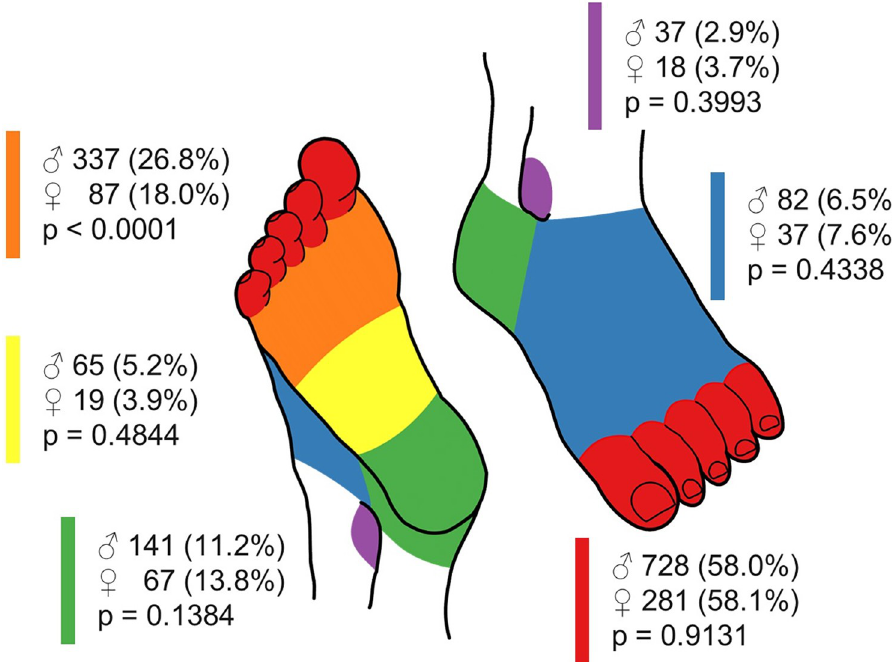
Fig 1. Location of the index DFU. A color-coded diagram was used by the DFC to indicate the location of the index DFU: Plantar forefoot (orange), plantar midfoot (yellow), heel (green), malleolus (purple), dorsum (blue) and toes (red). The number and proportion (%) of men and women with a DFU at a known location is indicated next to the respective color. The sum of percentages can exceed 100%, as a DFU can span multiple locations. The proportions of both groups were compared using generalized estimating